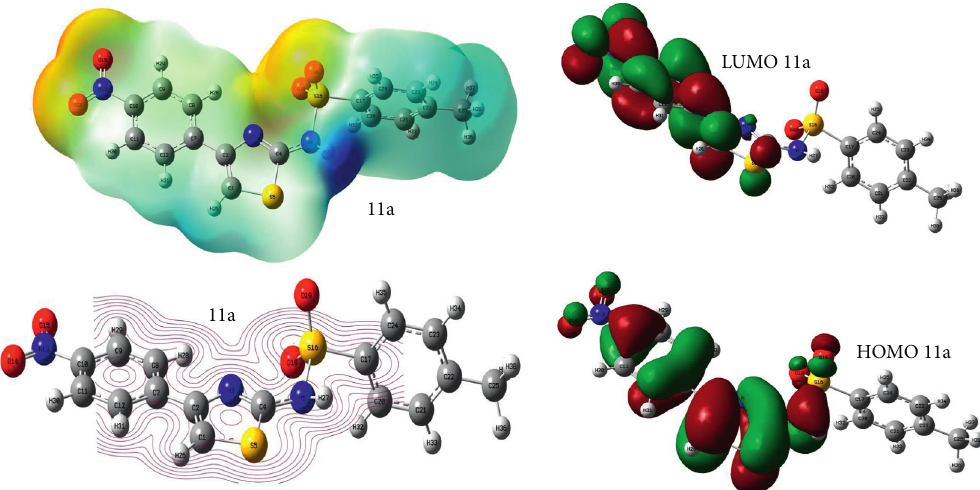
Figure 8: Optimized structures of compound 11a showing electrostatic potential surface, 2D contour, and HOMO-LUMO